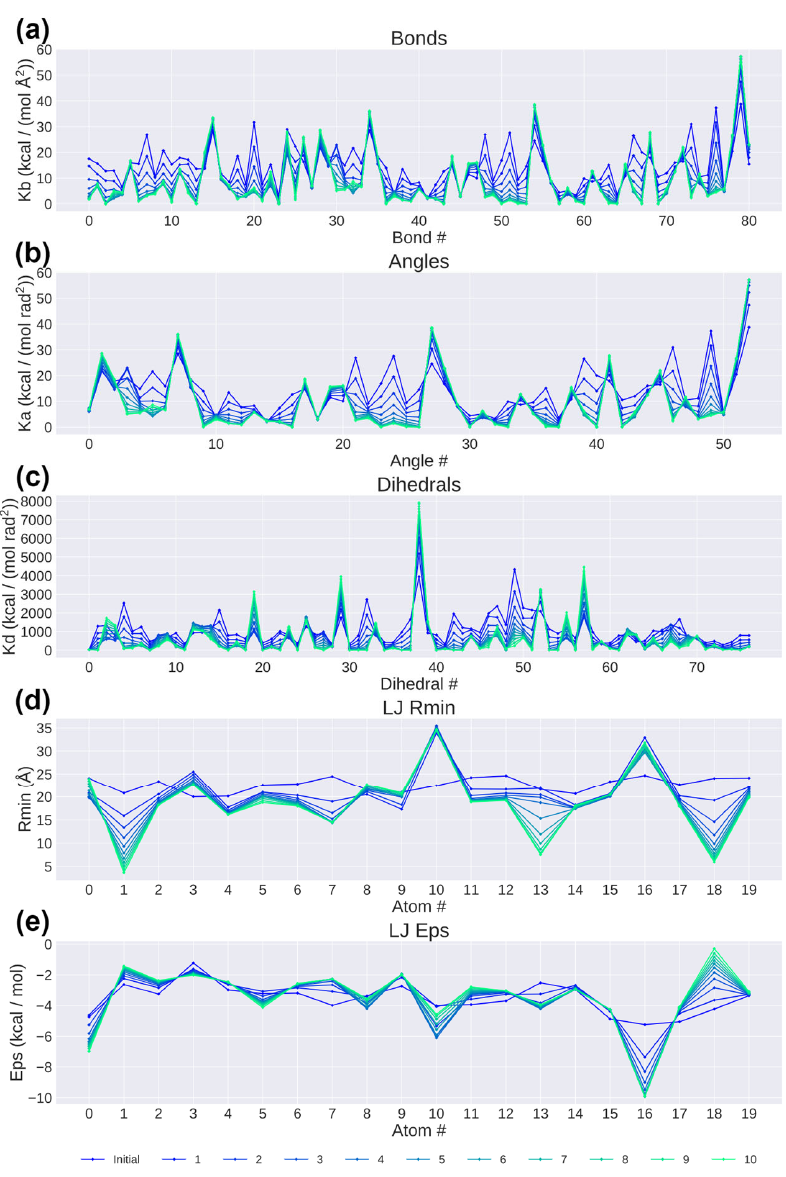
Figure A4. Physics-informed parameter learning for over 10 epochs. Bonds ( a ); angles ( b ); dihedrals ( c ); LJ Rmin ( d ); LJ Epsilon ( e ).